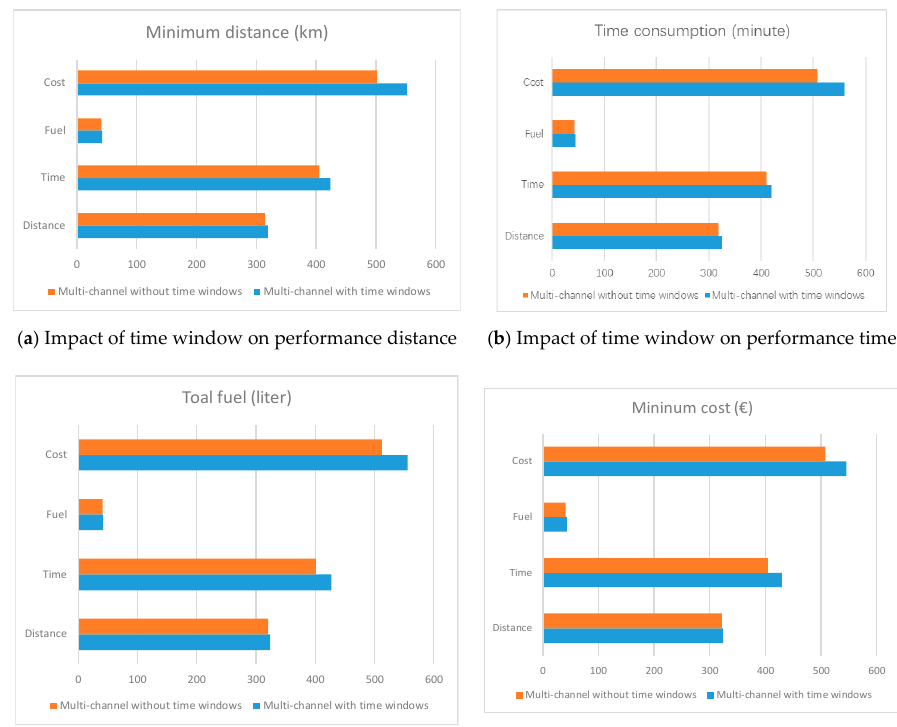
Figure 4. Impact of time window on performance indicators.